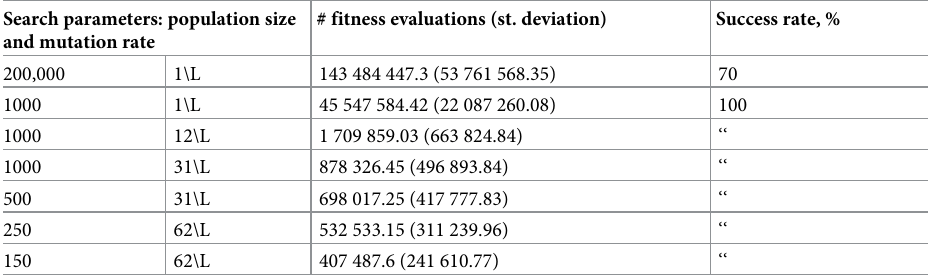
# fitness evaluations (st.